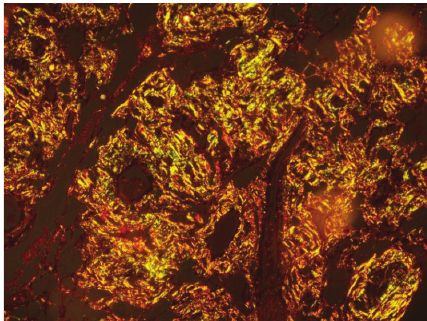
Figure 3: Section of thyroid gland with positive apple-green birefringence to Congo Red stain under polarized light